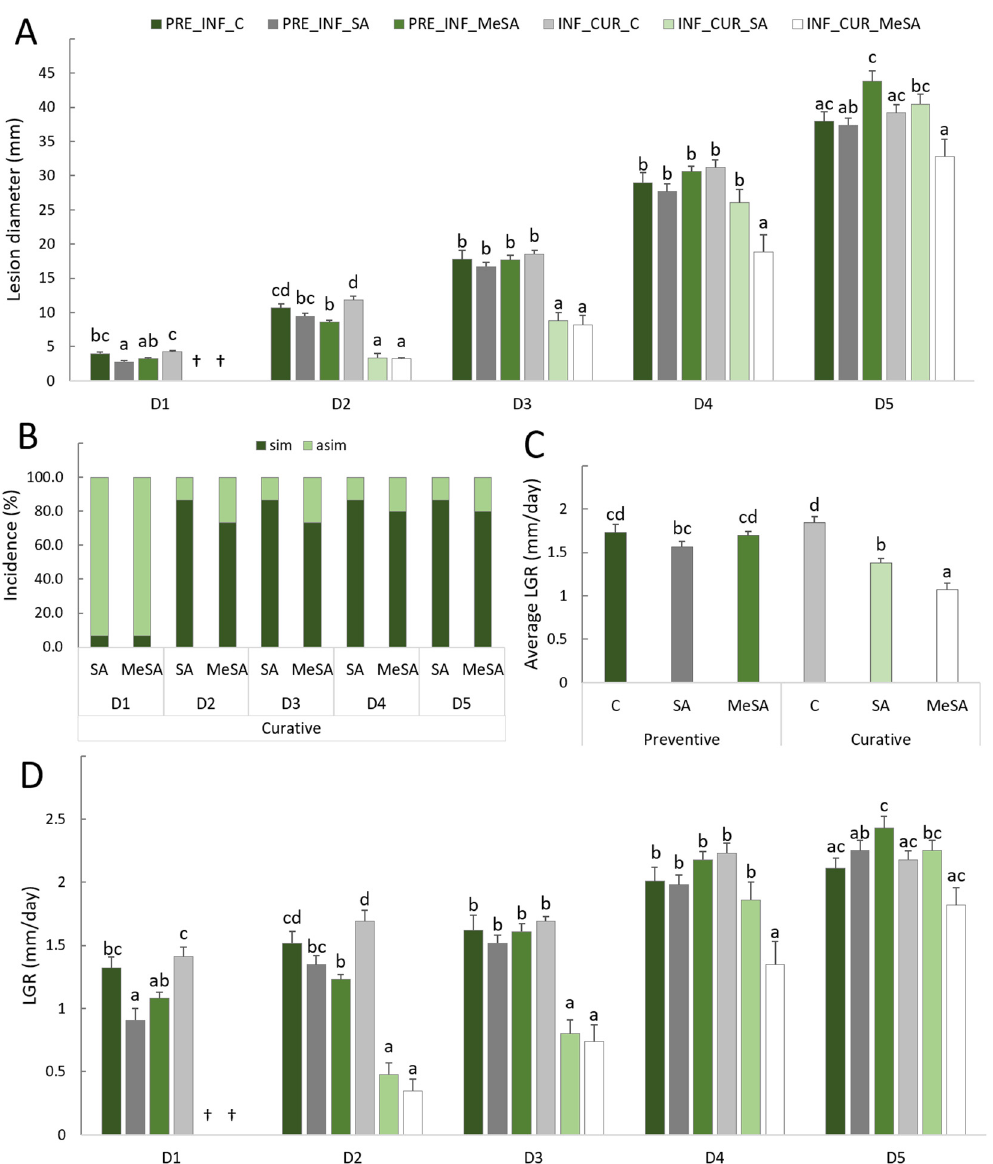
Figure 1. Curative (cur) and preventive (pre) treatments of apple fruits with 2.5 mM SA and MeSA solutions and infection with M. laxa ( A ) severity (mm) on different sampling dates after infection (after 3 days (D1), 7 days (D2), 10 days (D3), 14 days (D4) and 18 days (D5)), ( B ) incidence (%) in symptomatic (sim) and asymptomatic (asim) fruit, ( C ) average lesion growth rate (LGR) in 18 days (mm/day) and ( D ) LGR on individual sampling dates (mm/day). Data represent the average ± standard error. Different lower letters indicate significant differences between the treatments (Tukey, p ≤